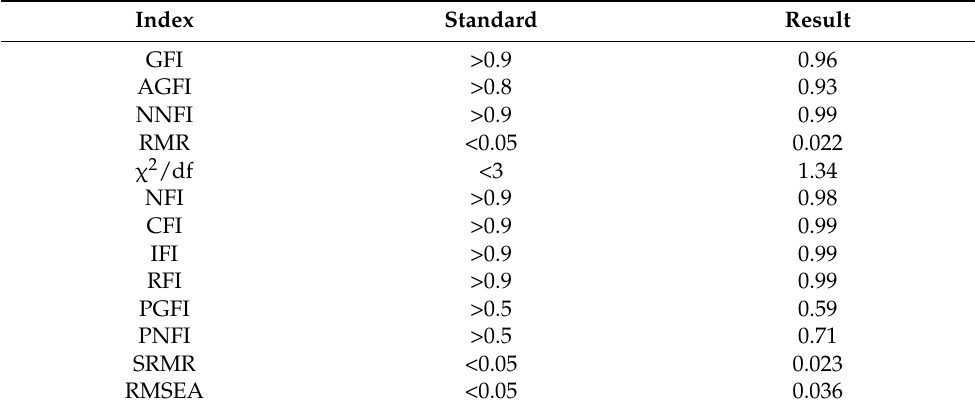
Table 5. Overall goodness-of-fit indices for this